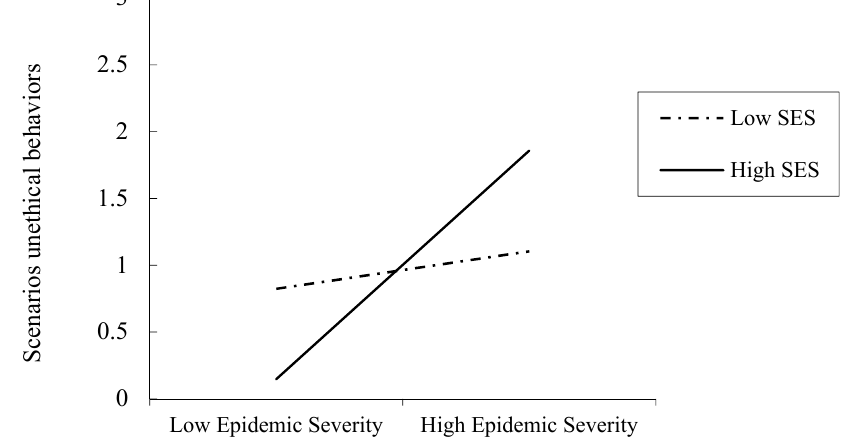
Figure 4. Unethical behavior scenarios as functions of epidemic severity and SES (Study 3).